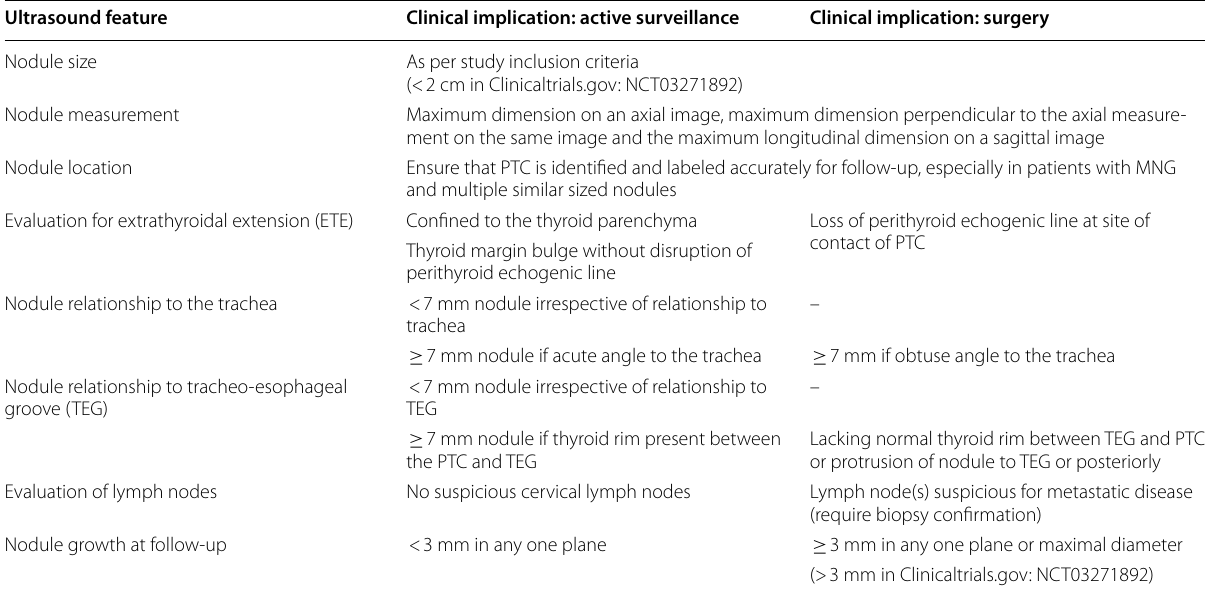
Table 1 Key ultrasound features with clinical implications of the findings Ultrasound feature Clinical implication: active surveillance Clinical implication: